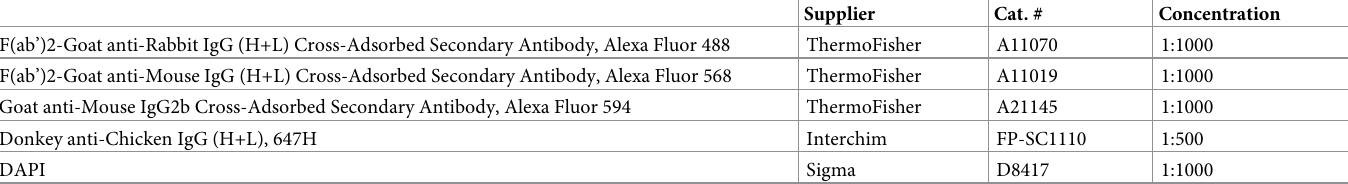
Table 2. Secondary antibodies.